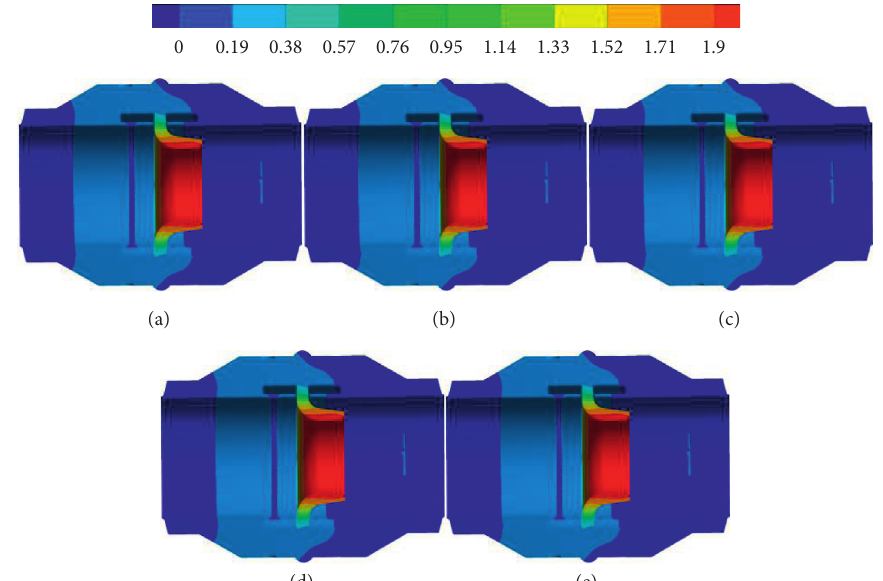
Figure 18: Deformation distribution in the section of fluid excitation (1000m 3 /h). (a) 50 ° C. (b) 100 ° C. (c) 300 ° C. (d) 500 ° C. (e) 700 °